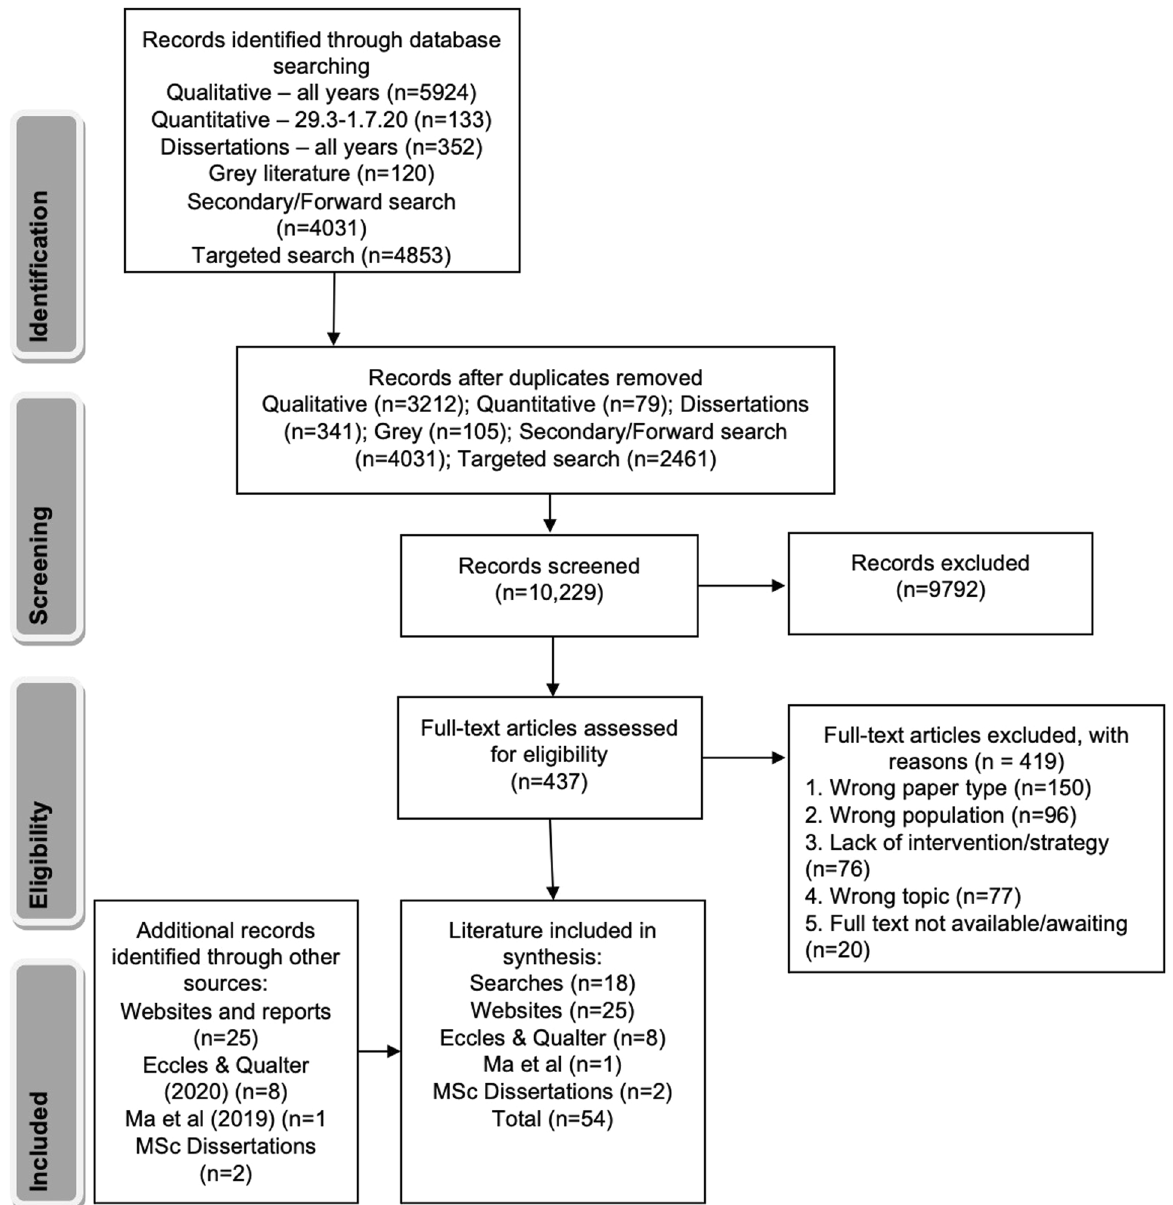
Fig. 1 PRISMA fl ow diagram of included and excluded evidence. The number ( n ) of records identi fi ed, screened by (i) title and abstract and (ii) full text, excluded (with reasons for exclusion) and included in the synthesis from different sources are